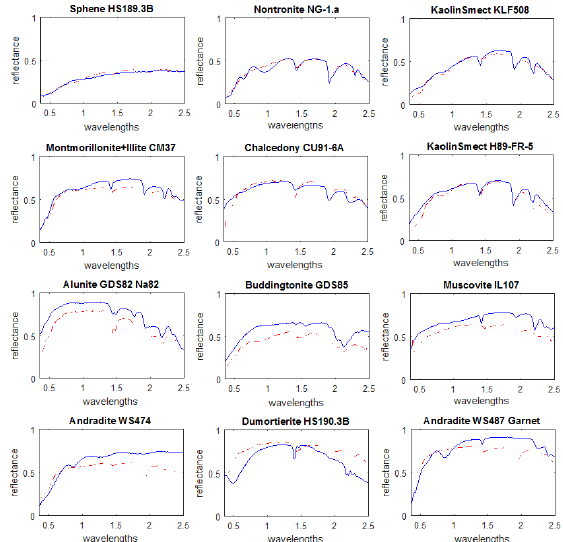
Figure 5. Original spectral signatures (blue solid lines) and estimated signatures using distributed unmixing with sparsity constraint (red dashed lines) versus wavelengths (µm), on AVIRIS dataset.